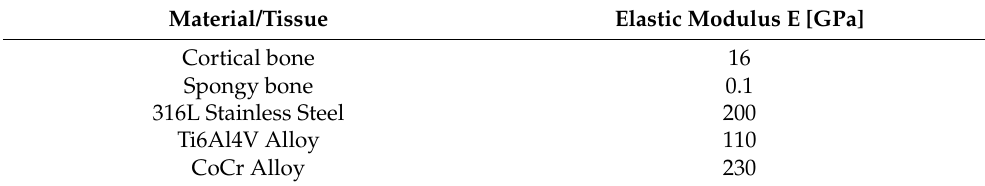
Table 1. Elastic modulus (E, GPa) of some metallic materials used for the production of hip prostheses, compared to cortical and spongy bone.